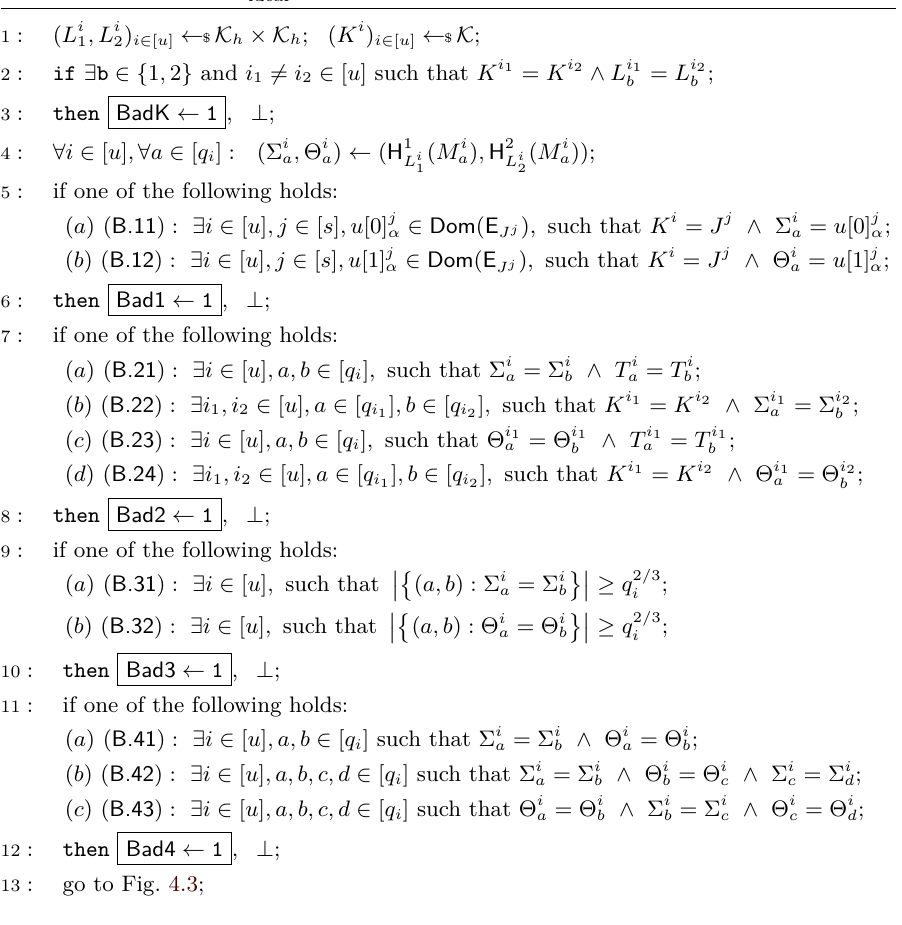
Figure 4.2: Offline Phase of the Ideal oracle $: Boxed statements denote bad events. Whenever a bad event is set to 1 , the ideal oracle immediately aborts (denoted as ⊥ ) and returns the remaining values of the transcript in an arbitrary manner. So, if the game aborts for some bad event, then we may assume that the previous bad events have not